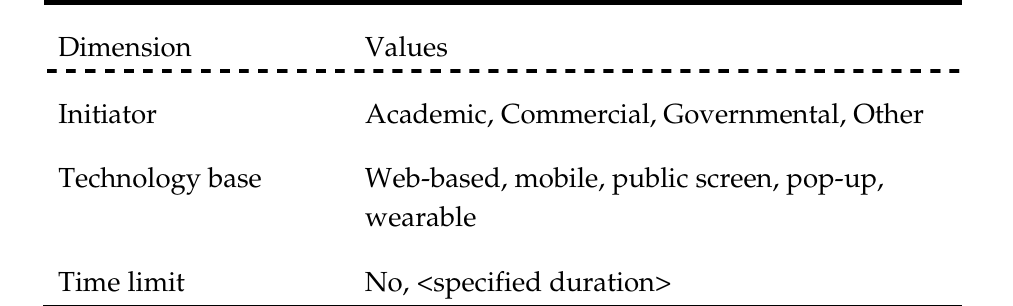
Table 4: The General Dimension of the Framework (Third